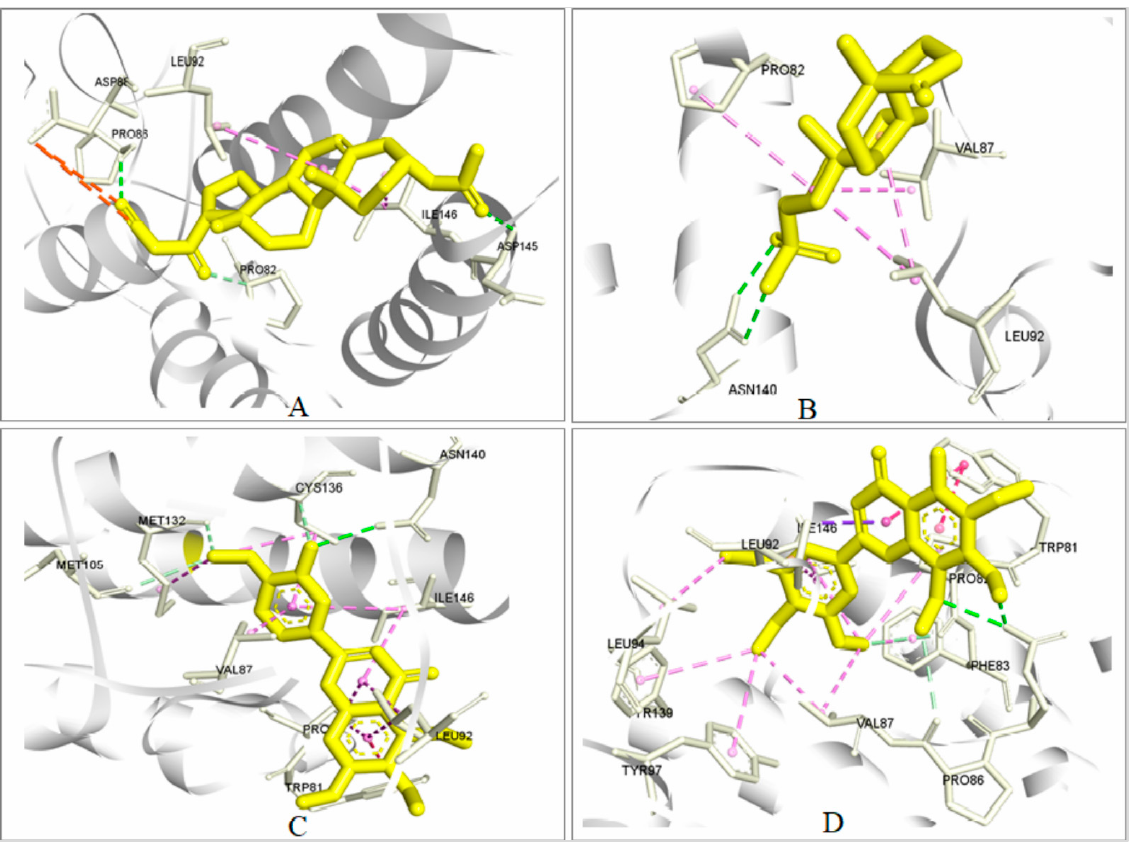
Figure 4. Three-dimensional interactions of the selected ligands with the protein complex. In our interactions, ( A ) ZINC4104882, ( B ) ZINC2509501, ( C ) ZINC2566088 and ( D ) ZINC1615112, and all showed better contact with the Brd4 protein. All four compounds were selected depending on the docking scores. The key amino acids in our interaction were LEU92, PRO82, GLN85, ASN140, and VAL87, and they were predominant in all the compound interactions.